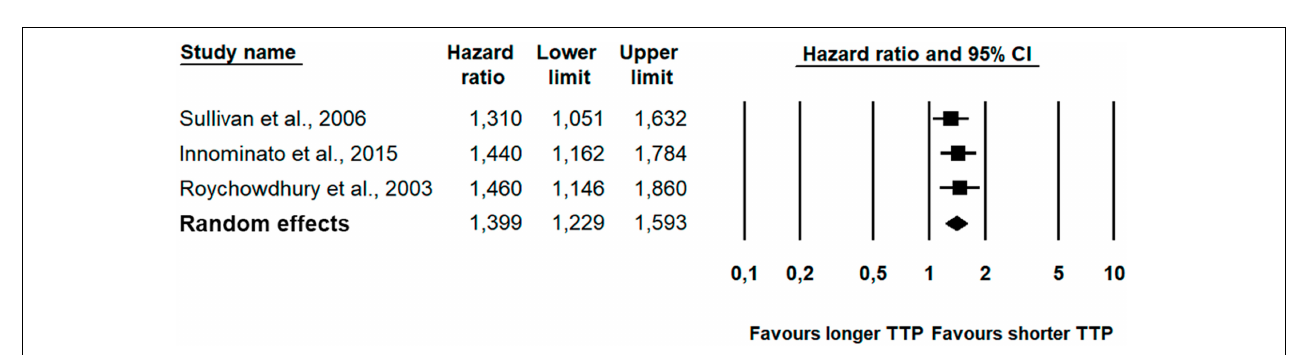
FIGURE 3 | Funnel plot of suggested publication bias.